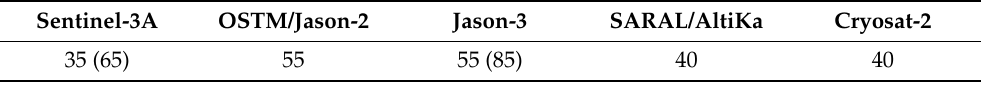
Table 2. Observable wavelengths with the full-rate (20 Hz or 40 Hz) altimeter measurement in the northeastern Atlantic Ocean [10, 35 ◦ W] [30, 65 ◦ N]. Observable wavelengths estimated from 1 Hz measurements over the same area and period are given in () for S3A and J3 missions. (units: